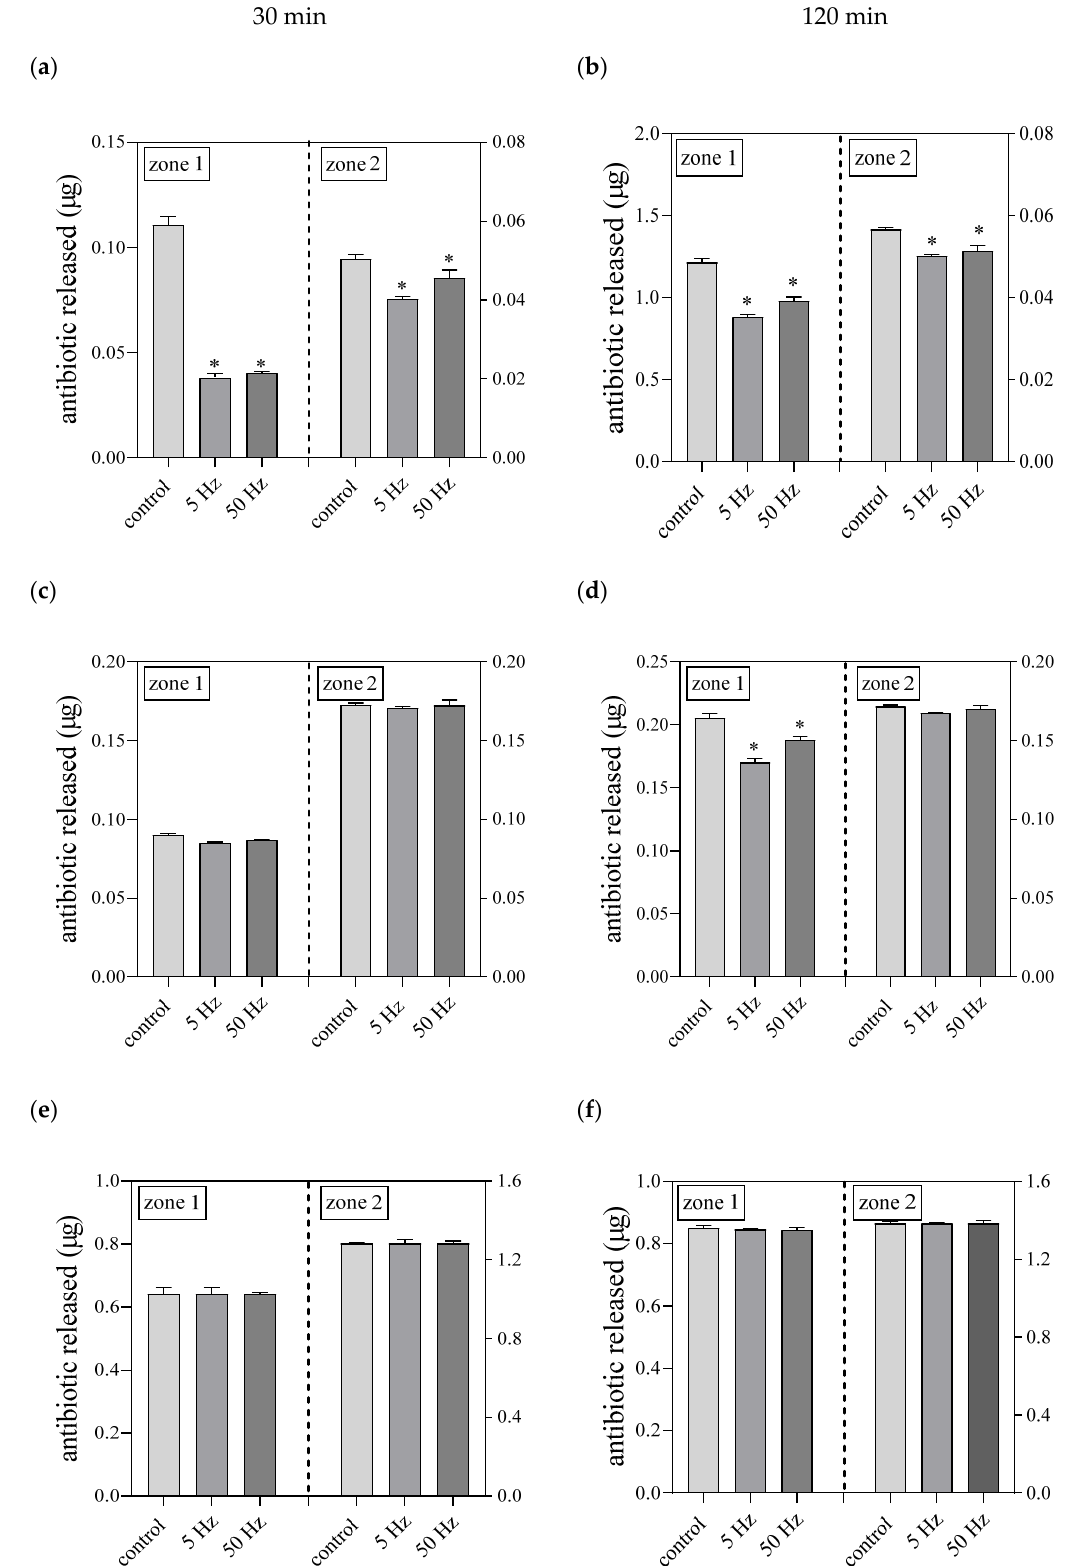
Figure 7. Concentrations of antibiotics in agar in control and RMF-exposed (5/50 Hz) settings; ( a , b ) cefoxitin; ( c , d ) cefepime; ( e , f ) imipenem. The results are presented as mean ± SEM calculated using six values (three from each biological replicate). *—indicates statistical differences ( p < 0.05) between control and RMF-exposed